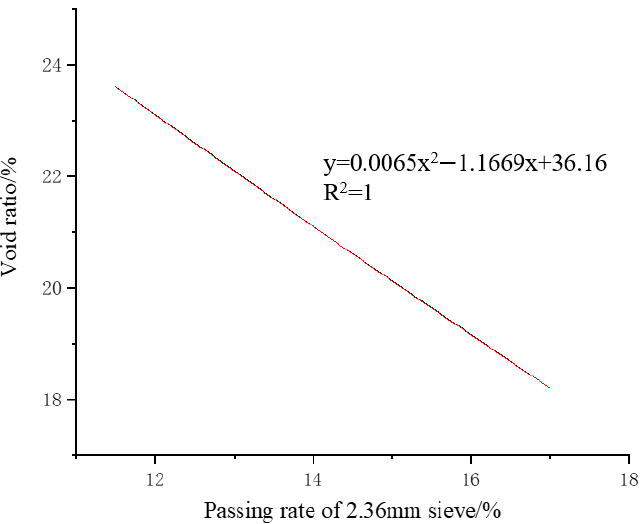
Figure 11. Relationship between passage rate and void fraction for 2.36 mm sieve pores.